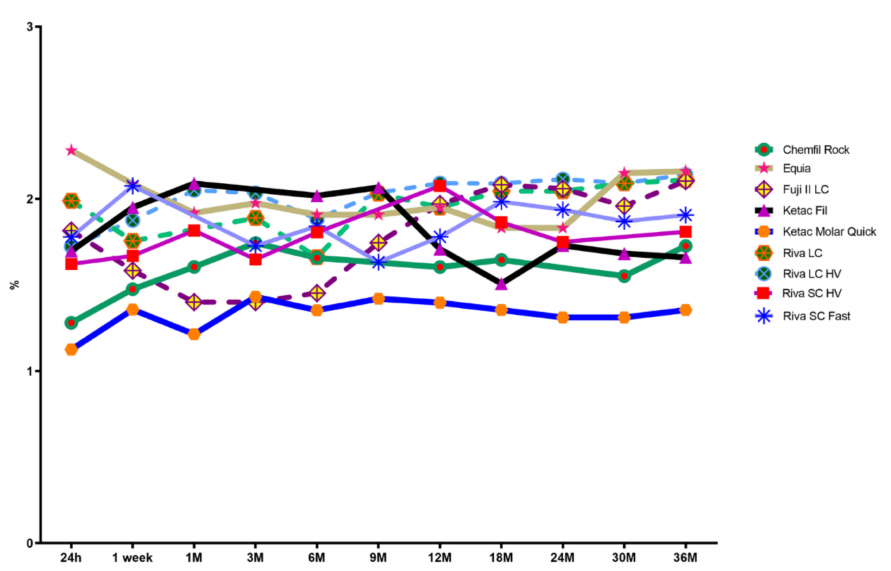
Figure 4. Mean Bound Water Content (%); n = 12; Bound water loss calculated as a percentage of total sample